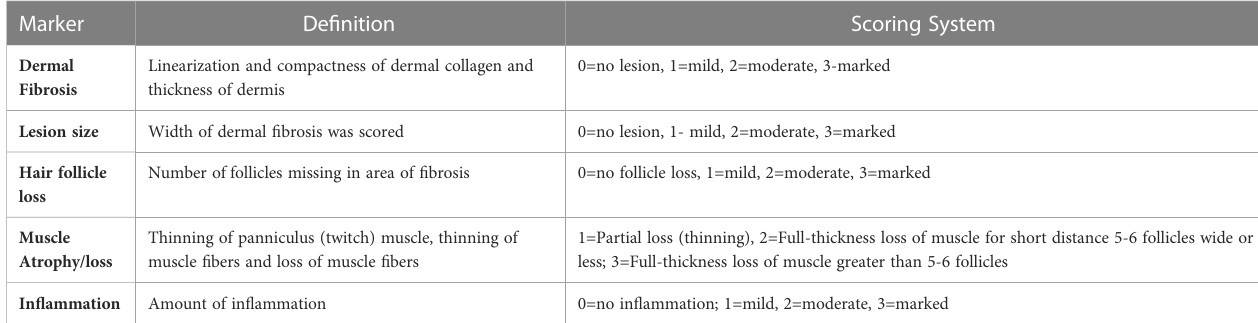
TABLE 1 Severity scoring of markers of tissue damage. Marker De fi nition Scoring System Dermal Linearization and compactness of dermal collagen and Fibrosis thickness of dermis Lesion size Width of dermal fi brosis was scored Hair follicle loss Muscle